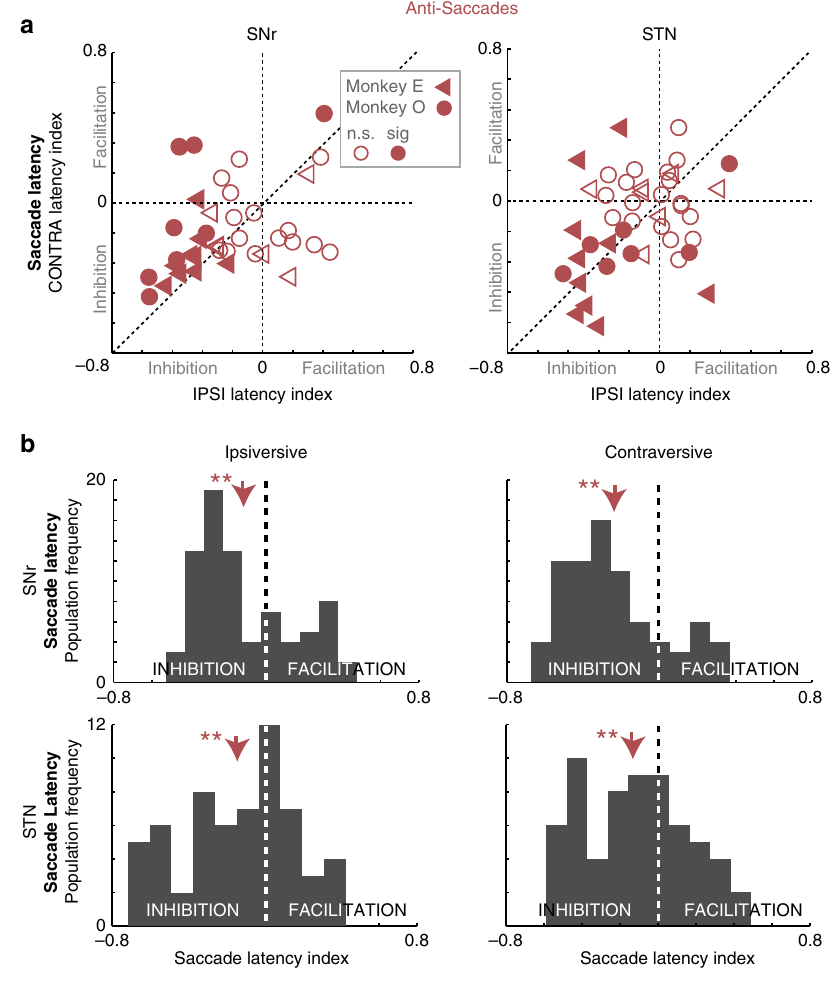
Fig. 4 SNr and STN stimulation both inhibited anti-saccades bilaterally. a Population saccade latency index after SNr or STN stimulation. Each point represents a single stimulation site (120 trials minimum). Filled points are signi fi cantly different from 0 (paired t -test, p < 0.05). n.s. not signi fi cant, sig signi fi cant. b Population histograms of change in ipsiversive (left panels) and contraversive (right panels) saccade latency after SNr or STN stimulation. Negative and positive values indicate increased and decreased saccade latency after stimulation, respectively. **signi fi cant difference (paired t- test p <